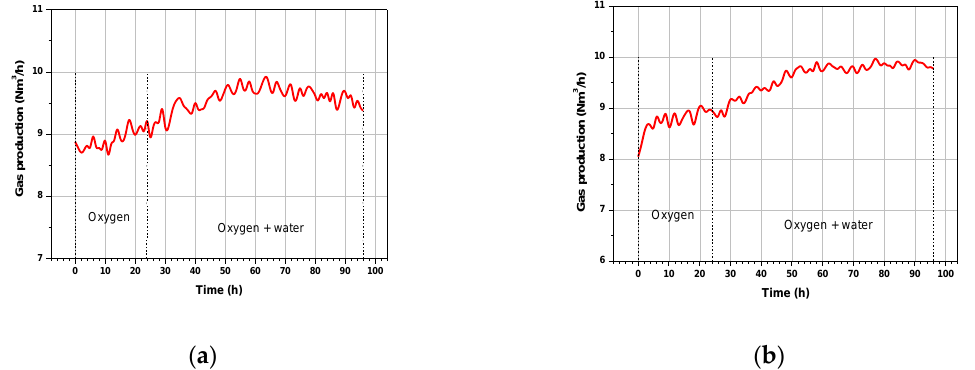
Figure 5. Gas production rates over the course of gasification experiments at 40 bar: ( a ) “Six Feet” semi-anthracite, ( b ) “Wesoła” hard coal.